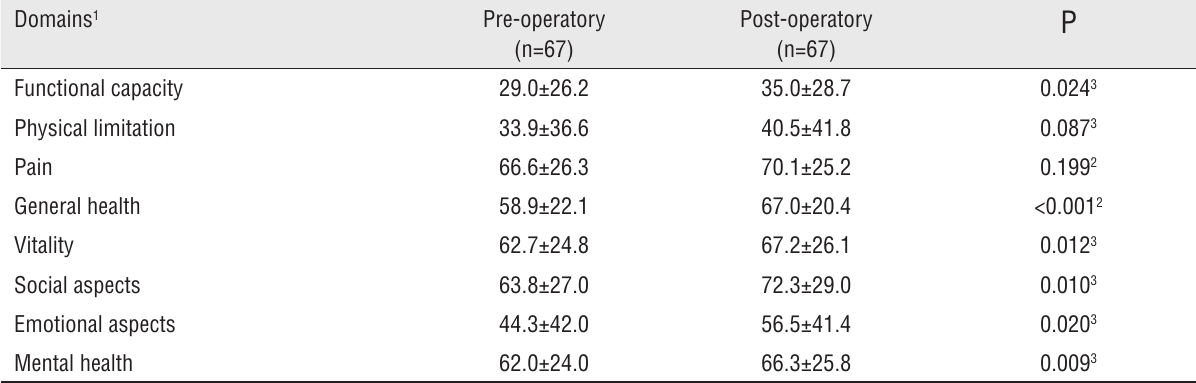
Table1 - Quality of life before and after surgery according to the SF-36® questionnaire. Domains 1